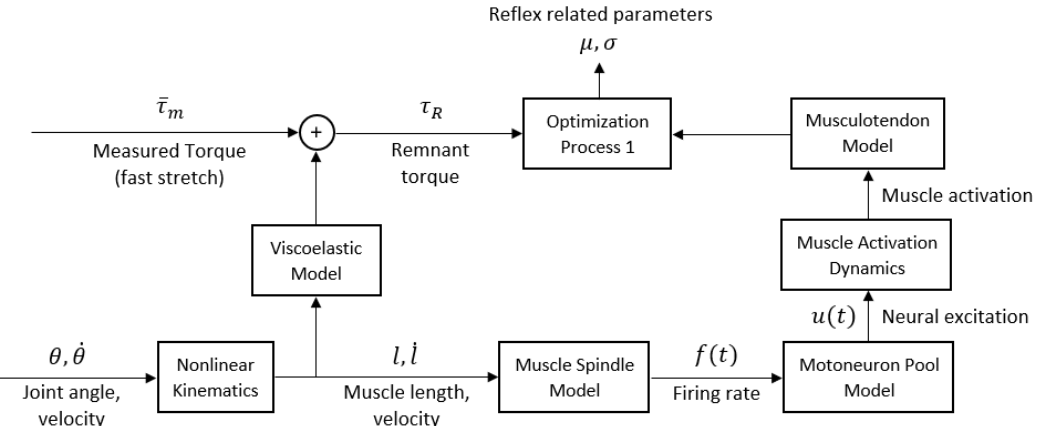
Figure 2. Example of system identification algorithm used by Shin et al. [69] for parameters characterizing the spastic reflexes, using muscle spindle, motor neuron pool, muscle activation dynamics, and musculoskeletal models to estimate the activate muscle torque generated by the spastic muscle during reflex.